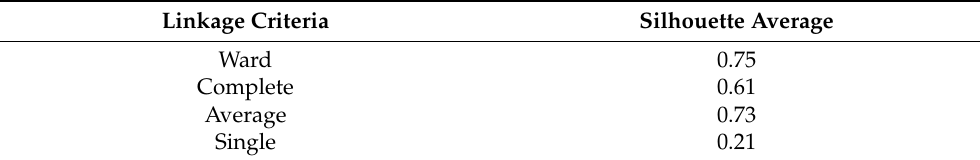
Table 1. Silhouette average score for different linkage criteria.